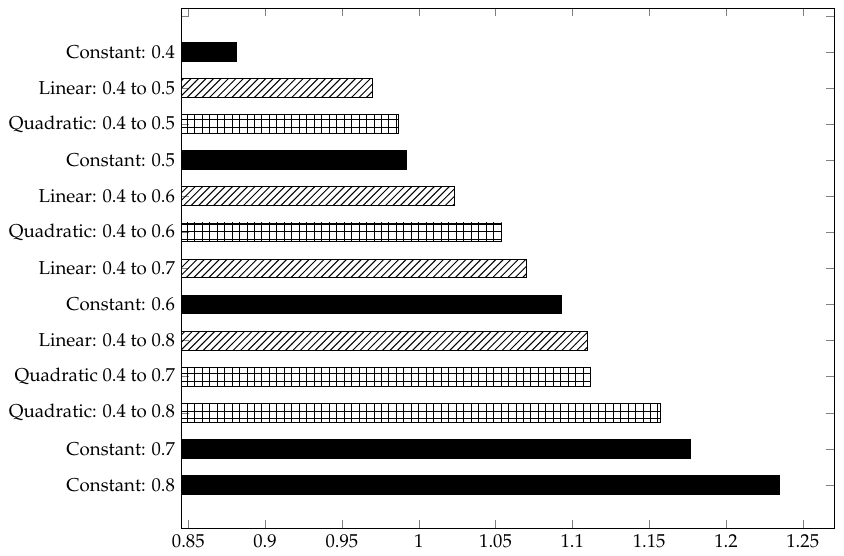
Figure 7. Dimensionless, scaled mean normalised stress ¯ σ VM of gyroid structures in ascending order.